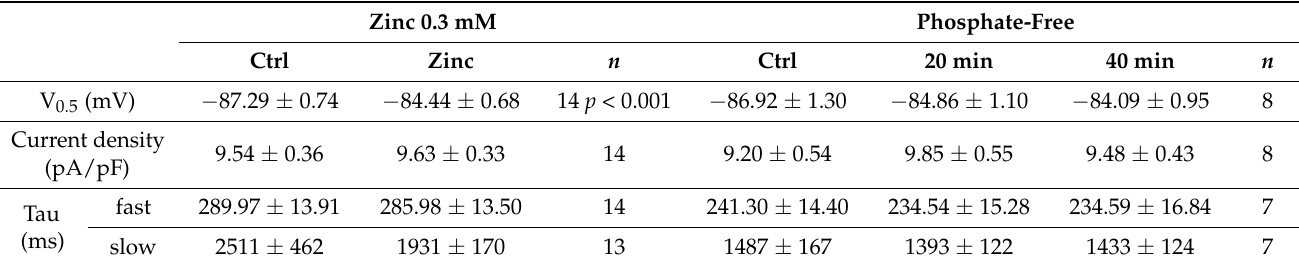
Table 2. The effects of zinc and phosphate-free conditions on I h current in TC neurons. The data are given as mean ± SEM. Control measurement and the corresponding substance effect were recorded from the same